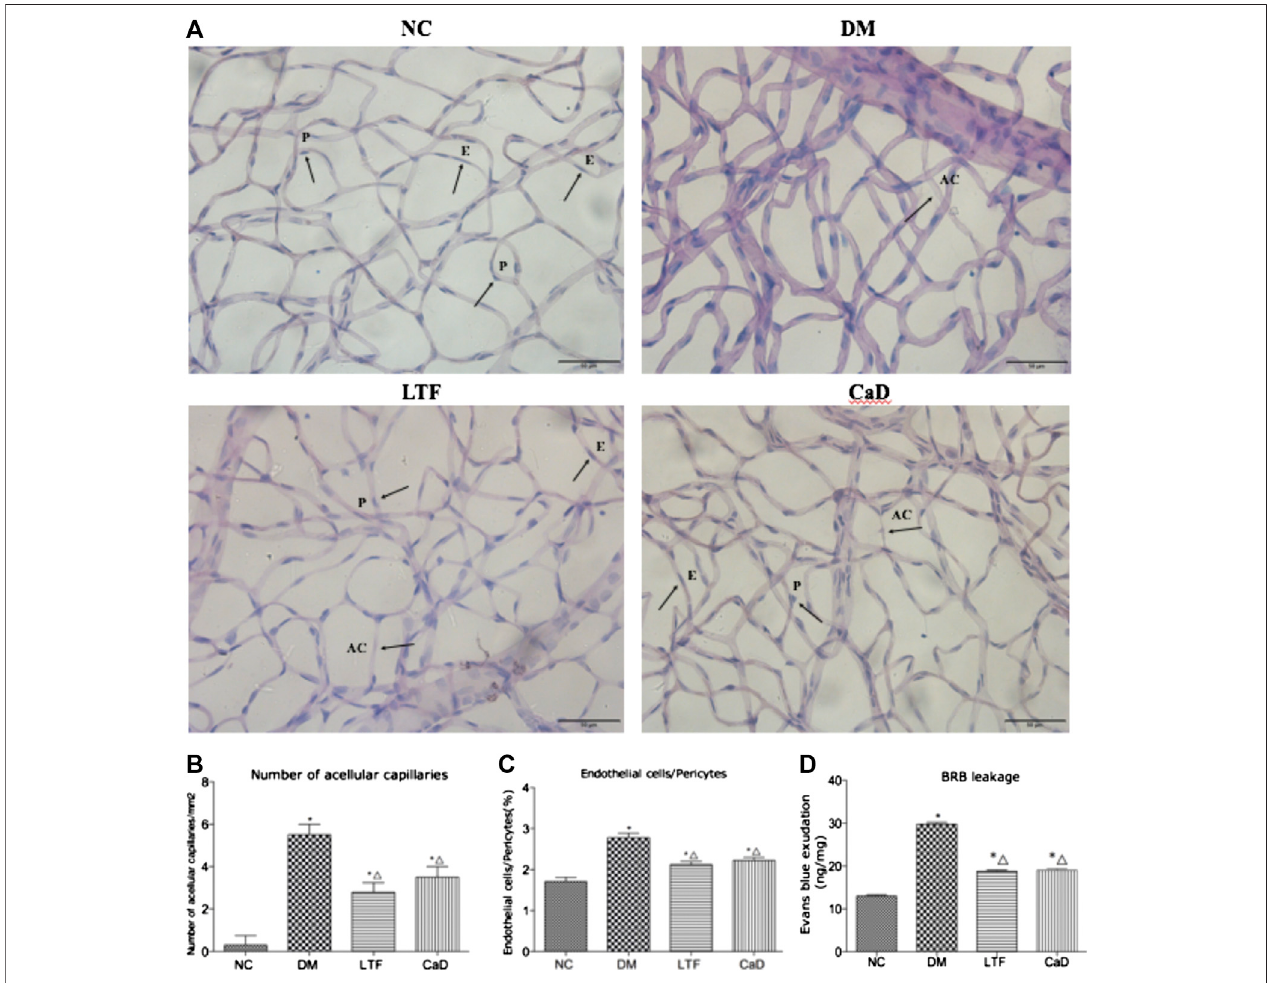
FIGURE4| EffectofLTFandCaDontheretinalvascularmorphologicalchangesandBRBleakage. (A) PASstainingofretinaat12weeks(400 × magni fi cation); (B) Number of acellular capillaries (Data are mean ± SD from six retinas per group); (C) The ratio of endothelial cells and pericytes (Data are mean ± SD from six retinas per group); (D) Measurement of BRB permeability (Data are mean ± SD from four retinas per group); (* p < 0.05: vs. NC group; △ p < 0.05: vs. DM group).